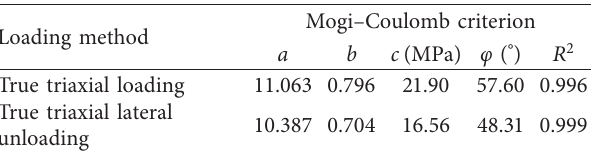
Figure 4: The deformation modulus and unloading ratio curves of the sandstone under different σ during true triaxial unloading. 2